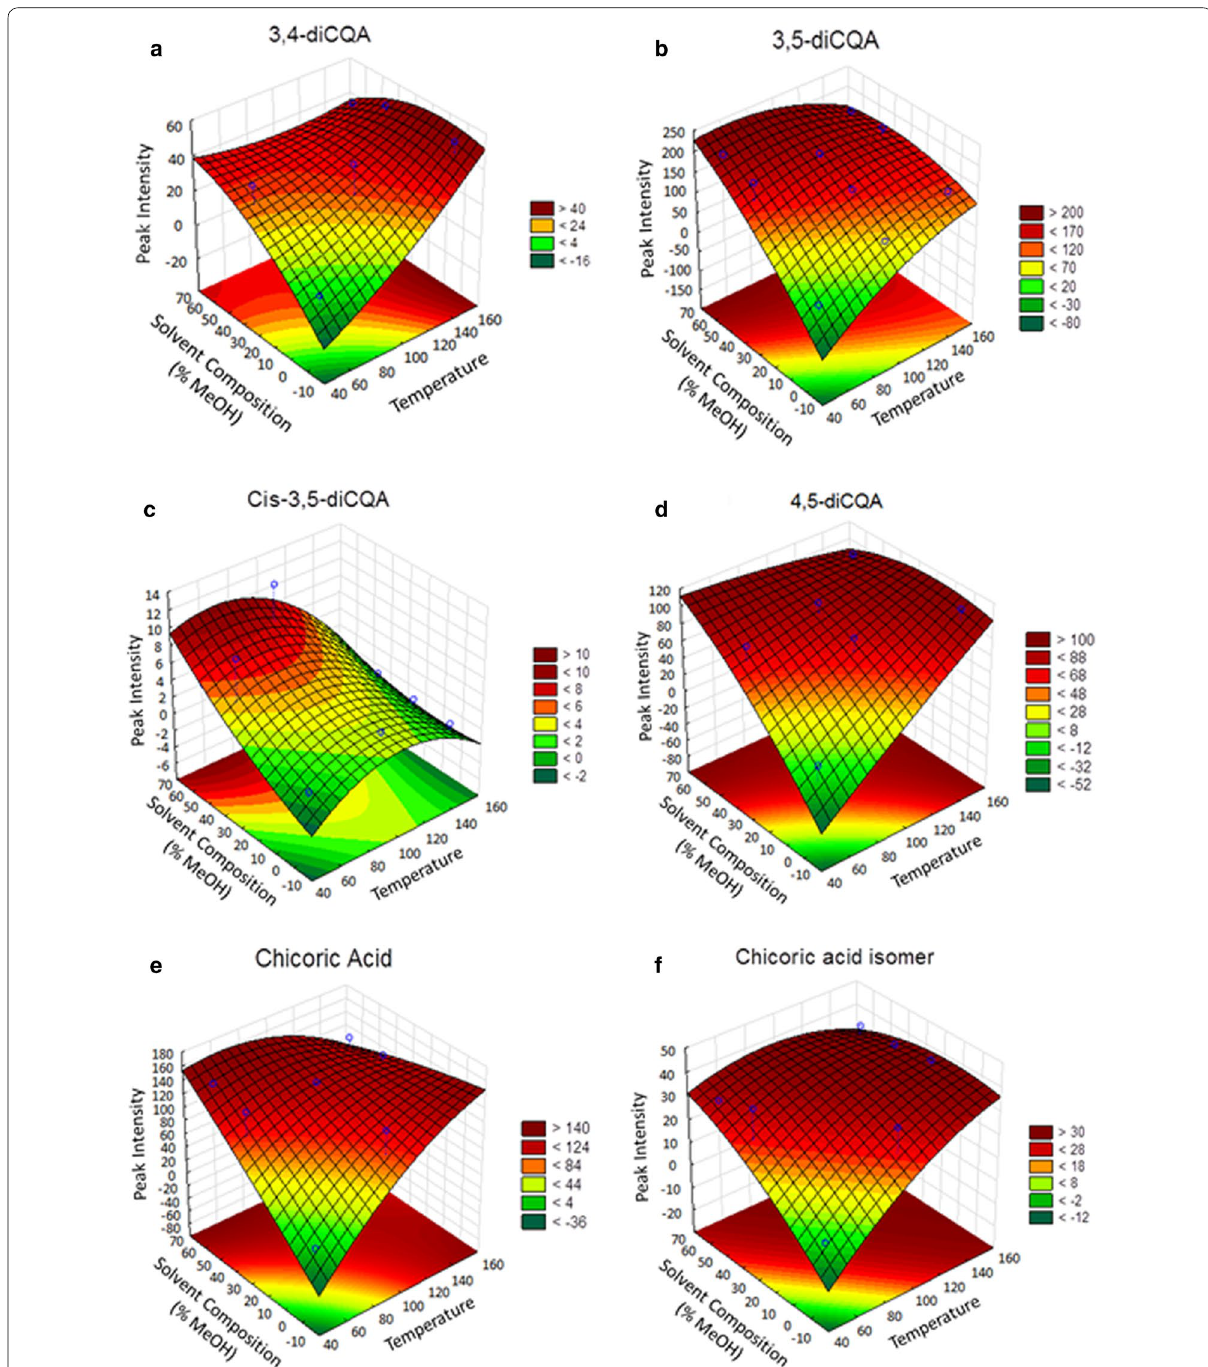
Fig. 5 Surface plots showing the effect of temperature and solvent composition on the extraction of diCQA and CA analogues: 3,4-diCQA ( a ), 3,5-diCQA ( b ), Cis -3,5-diCQA ( c ), 4,5-diCQA ( d ), CA ( e ) and CA isomer ( f